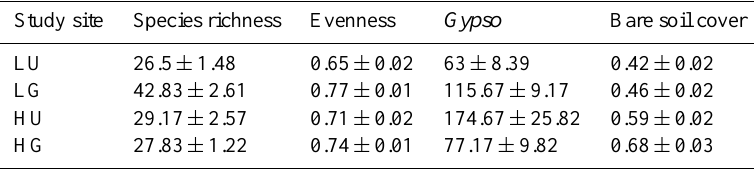
Table 2. Characteristics of the plant community at the four study sites in the middle Ebro Valley, Spain.